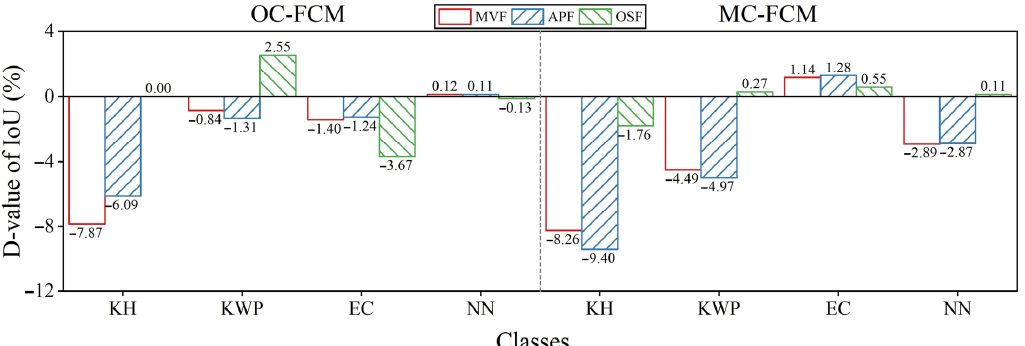
Figure 23. Difference between the IoU of FCMs based on different strategies and the best IoU of the single CNN models before fusion for karst wetland